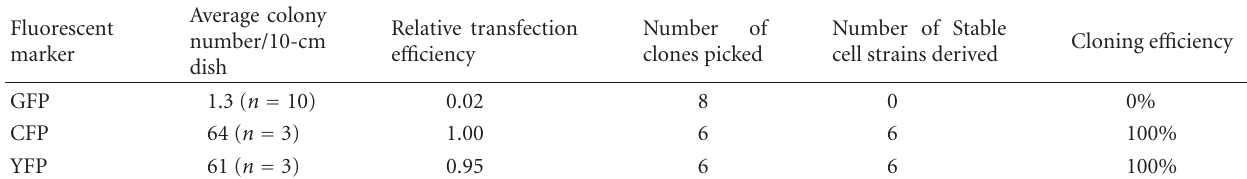
Table 1: Relative transfection e ffi ciency of fluorescent gene markers and cloning e ffi ciency of selected transfected cell colonies . Transfection e ffi - ciency is defined as the average number of colonies/estimated number of cells transfected/ μ g DNA. Transfections included ∼ 1 . 5 × 10 6 cells. Cloning e ffi ciency is defined as the number of stable cell strains derived/number of colonies cultured.